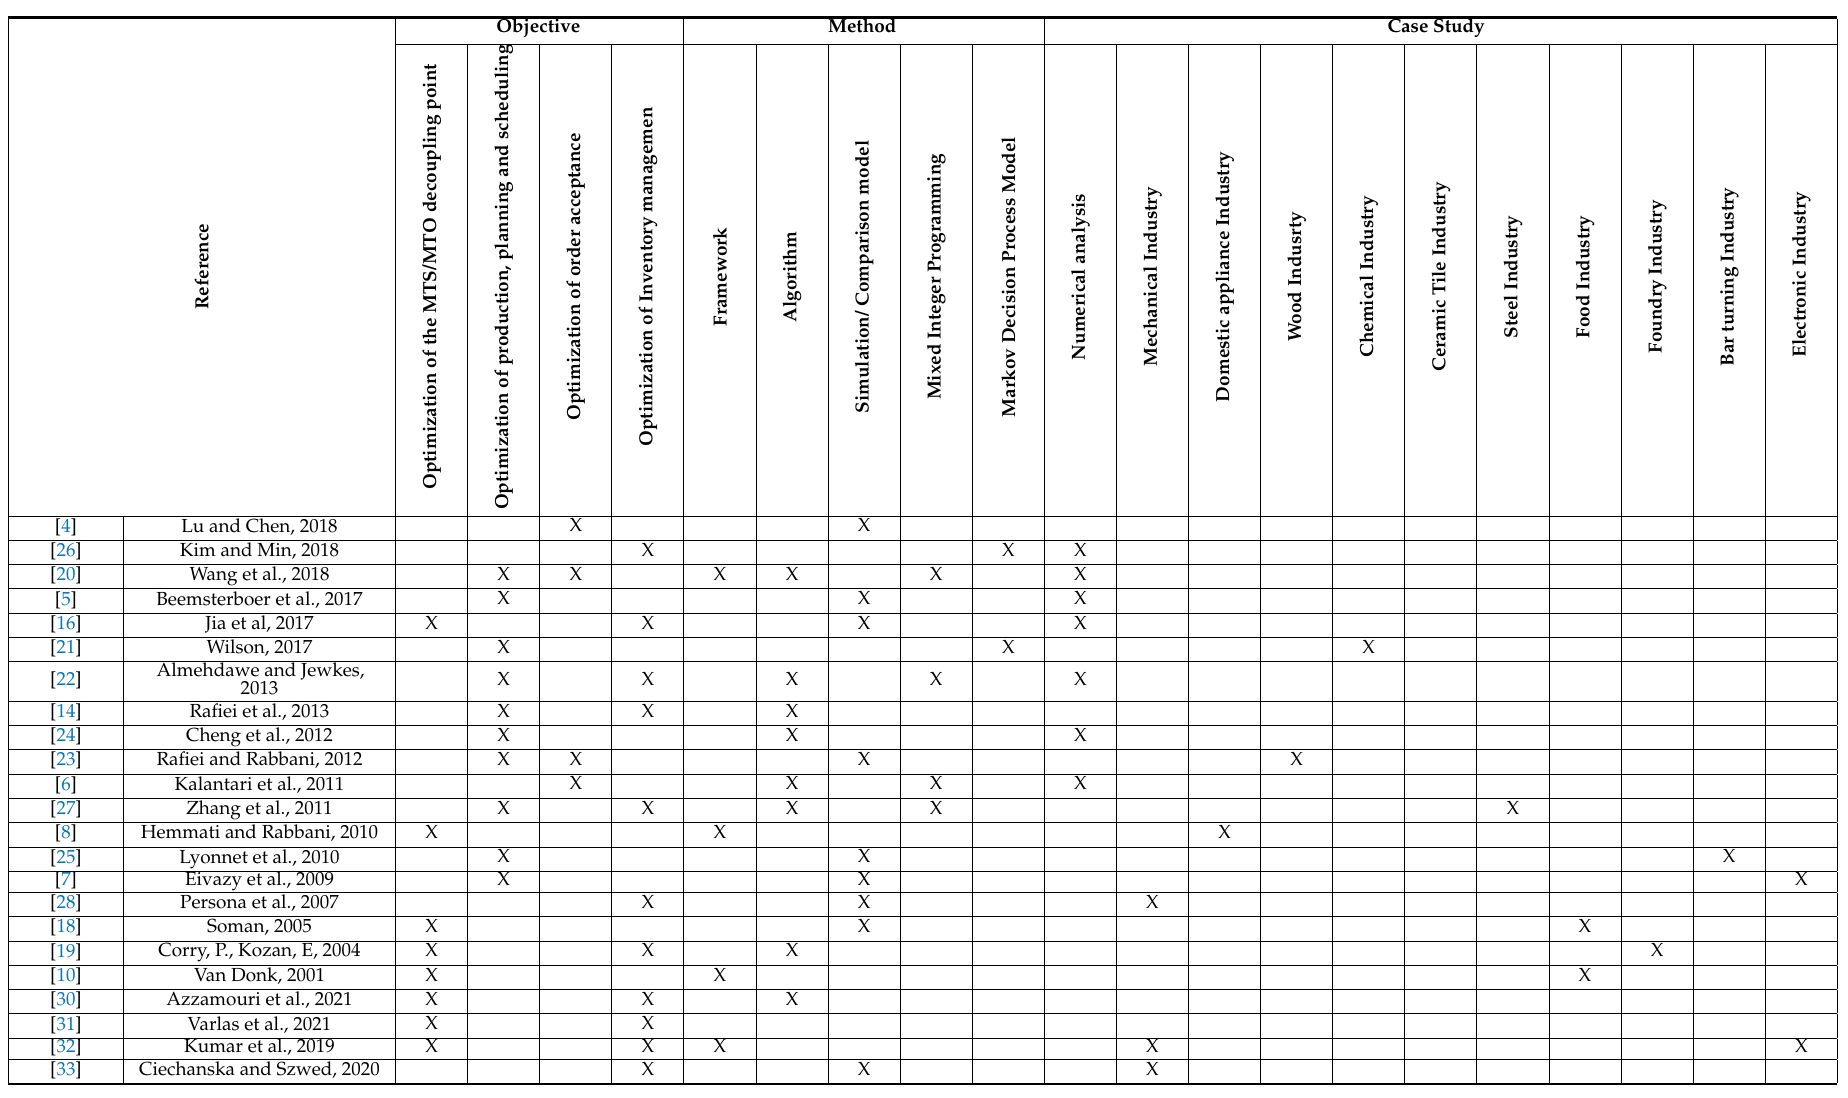
Table 1. Hybrid PUSH/PULL literature